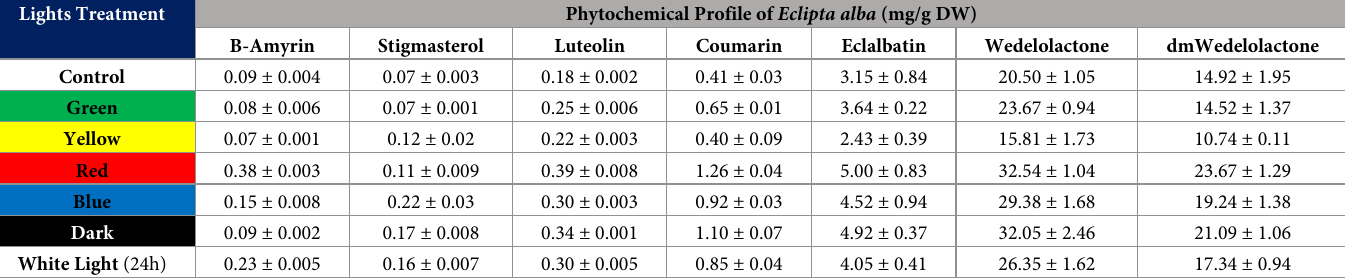
Table 2. Secondary metabolites accumulation under multi spectral lights in callus culture of E . alba . Values represent means ± standard errors from triplicates. Lights